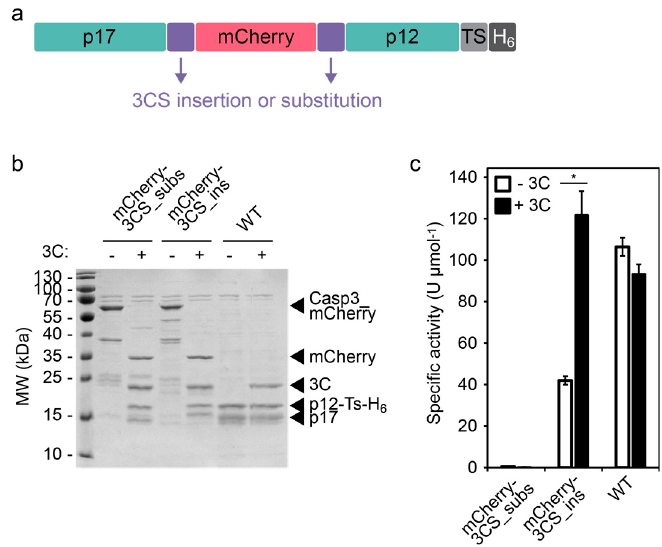
Figure2. Incorporationofabulkyand3Cprotease-removableproteindomainintoCASP3. ( a )Schematic design of CASP3 with an incorporated fluorescent protein. The red fluorescent protein mCherry was positioned between the large (p17) and small (p12) subunits of CASP3. 3C protease cleavage sites (3CS) were incorporated either by the insertion or substitution strategy (see Figure 1). H 6 , hexa-histidine tag; TS, TEV protease cleavage site. ( b ) Cleavage of CASP3 constructs by 3C protease. The constructs mCherry-3CS_subs (3.9 µ M), mCherry-3CS_ins (3.7 µ M), and WT (6.4 µ M) were incubated in the absence ( − ) or presence ( + , 2.4 µ M) of 3C protease (3C) for 4 h and analyzed using SDS-PAGE. ( c ) Activity of CASP3 constructs. The indicated constructs were incubated in the absence ( − 3C) or presence ( + 3C) of the 3C protease as described in (b). The specific activity of CASP3 in 1:100-diluted samples was determined using a synthetic peptide substrate. Mean values of three replicates +/ − s.e.m. are shown. Statistics: unpaired t-test; * p < 0.05. Construct abbreviations: mCherry-3CS_subs, CASP3 with incorporated mCherry and substituted cleavage site; mCherry-3CS_ins, CASP3 with incorporated mCherry and inserted cleavage site; WT, wild-type